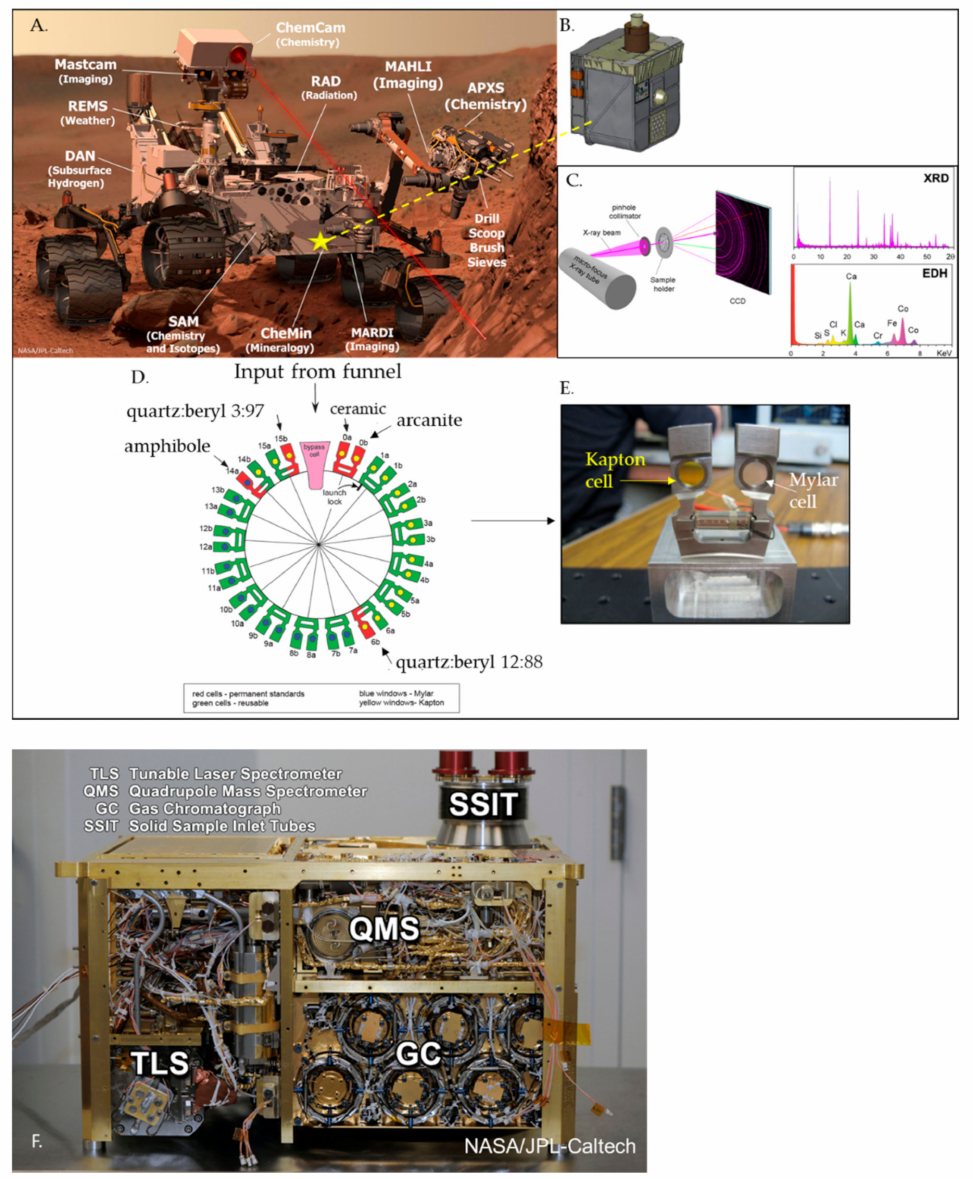
Figure 6. ( A ) Curiosity rover science payload with the CheMin instrument identified with a yellow star. CheMin and SAM instruments reside in the interior of Curiosity and have sample inlets that protrude through the top deck. Image credit: NASA/JPL-Caltech. ( B ) A schematic of the CheMin instrument (about the size of a laptop inside a carrying case). ( C ) A schematic demonstrating the basic components of CheMin which includes sample within a holder in transmission geometry with a cobalt X-ray source penetrating the sample. Diffracted X-rays are collected on a CCD, and the resulting 2D patterns are converted into a 1D pattern. ( D ) CheMin sample cell wheel that contains 27 reusable sample cells (green) and 5 standards (red). Of the reusable cells, 14 are Mylar (blue circles) and 13 are Kapton (yellow circles). ( E ) CheMin laboratory analog cells with Kapton (yellow) and Mylar cells (colorless) ( B – E ) [26]. ( F ) SAM Instrument suite that is about the size of a microwave oven, and the 3 instruments visible include: The tunable laser spectrometer (TLS) (lower left), quadrupole mass spectrometer (QMS) (upper right, and gas chromatograph (GC) (lower right). The solid sample inlet tubes (SSIT) is visible at the top right and is used for delivery by the robotic arm to deliver samples. Image credit: NASA/JPL-Caltech, accessed on 23 July